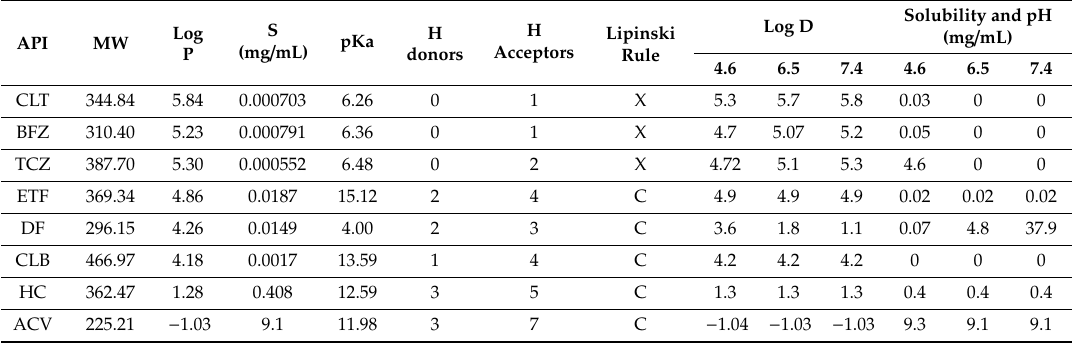
Table 11. In silico prediction of several physicochemical descriptors obtained from the molecule structure using Chemaxon